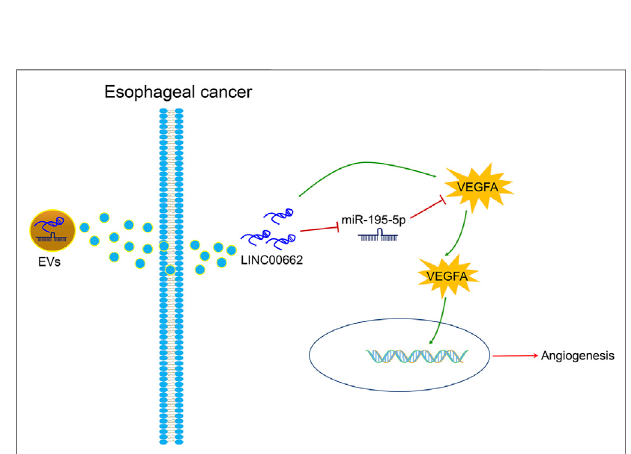
FIGURE 9 | ESCC cells-derived EVs transferal of up-regulation of LINC00662 to promote angiogenesis in esophageal cancer by downregulating miR-195-5p and upregulating